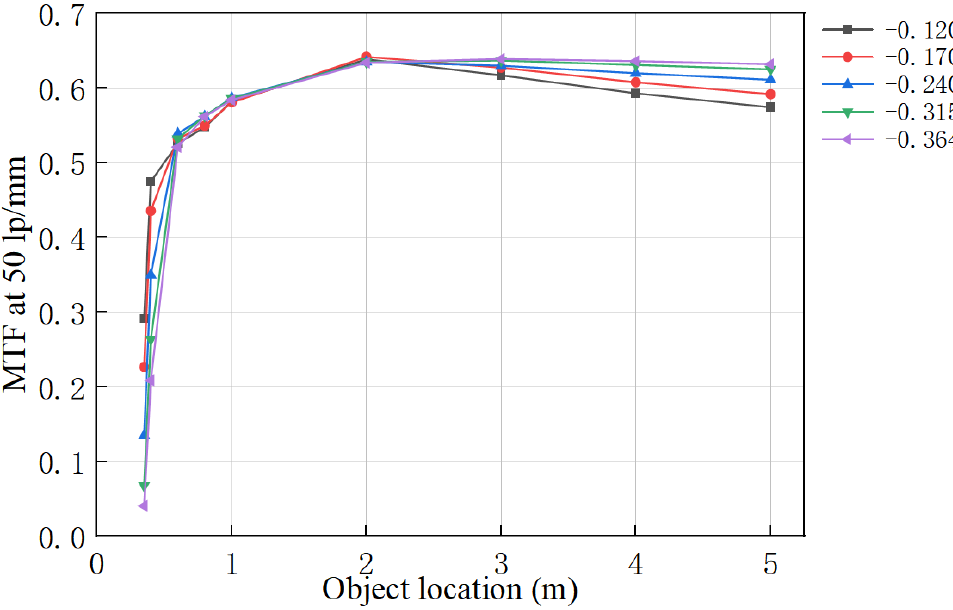
Figure 6. MTF at 50 lp/mm as a function of the object distance for pseudophakic eye models with different corneal aspherical coefficients of −0.120, −0.170, −0.240, −0.315 and −0.364. (3 mm pupil diameter and 0° field of view).